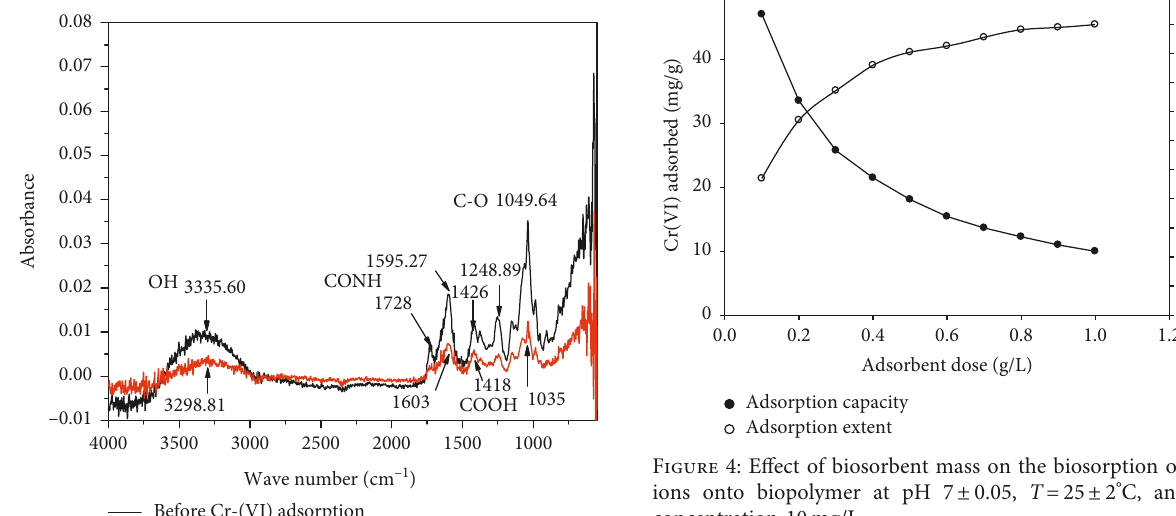
0.05, T 25 2 ° C, and initial (cid:31) ± ±